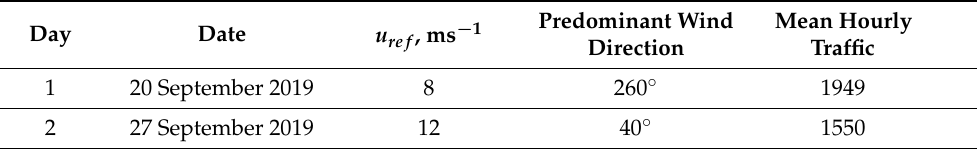
Table 1. Inlet velocity configuration for the two field study days. u ref is the reference velocity at the domain height of